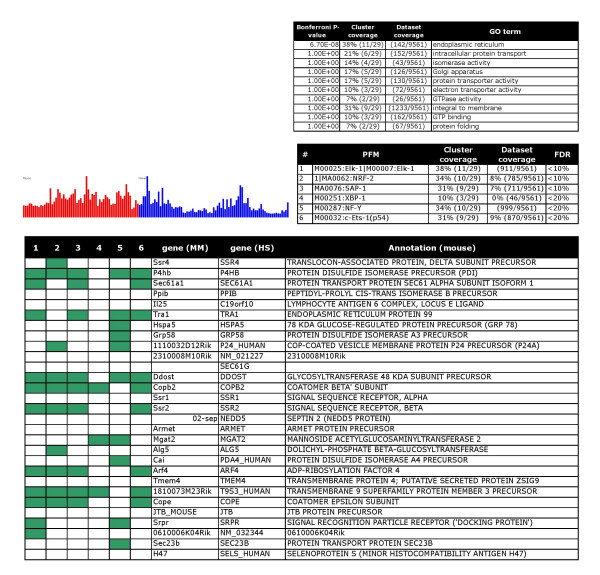
Endoplasmatic reticulum associated genes: Over representation of XBP-1, NRF and RTS motifs suggest novel functions for NRF and ETS family factors in the regulation of ER-related genes. Tables and charts are organized as in figure 2.